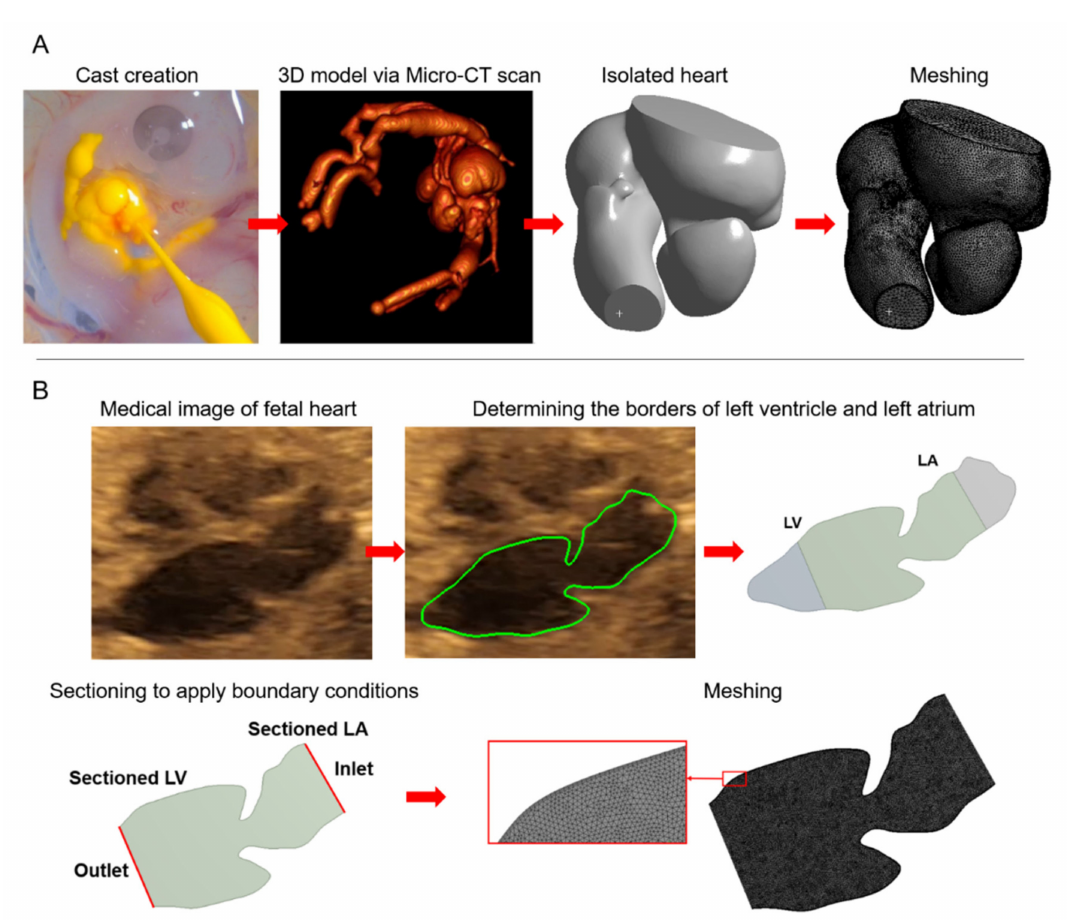
Figure 1. 3D and 2D models of computational fluid dynamics (CFD) simulations for a Hamburger–Hamilton 30 stage (HH30) chicken embryo and a 24-week human fetus. ( A ) A cast is created by perfusing Microfil in the embryonic chicken heart. The 3D model is obtained via micro-CT scan. The heart with four chambers is isolated and then sectioned to apply boundary conditions. In the last step, the isolated 3D heart model is meshed to perform CFD analysis. ( B ) Echocardiography image shows four chambers in a fetal human heart. Borders of the left side of the heart are determined and shown by green lines. Left atrium (LA) and left ventricle (LV) are isolated and sectioned to apply boundary conditions. Finally, 2D model geometry is meshed to perform CFD